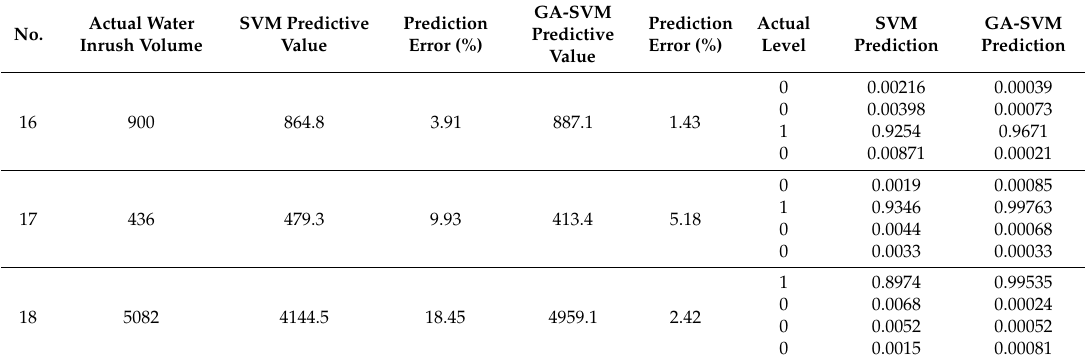
Table 6. Predictive values of SVM and GA-SVM.